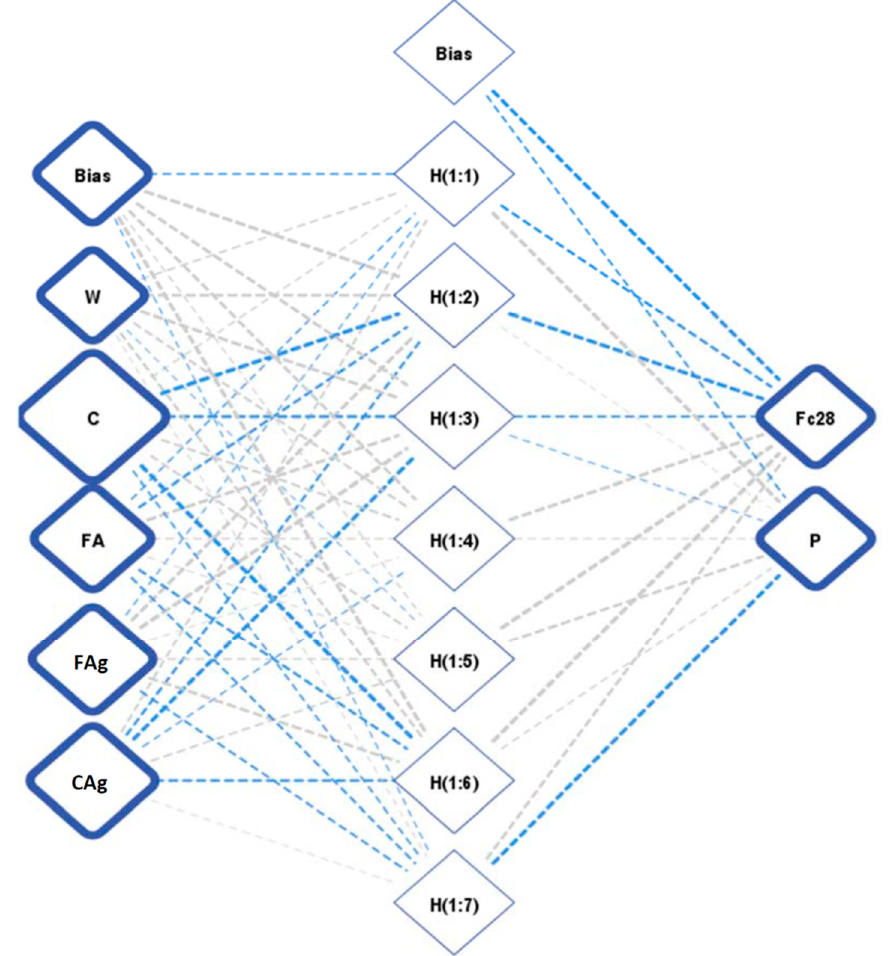
Figure 3. Architecture layout for the developed ANN models. Table 4. Weights matrix for the developed ANN-BP